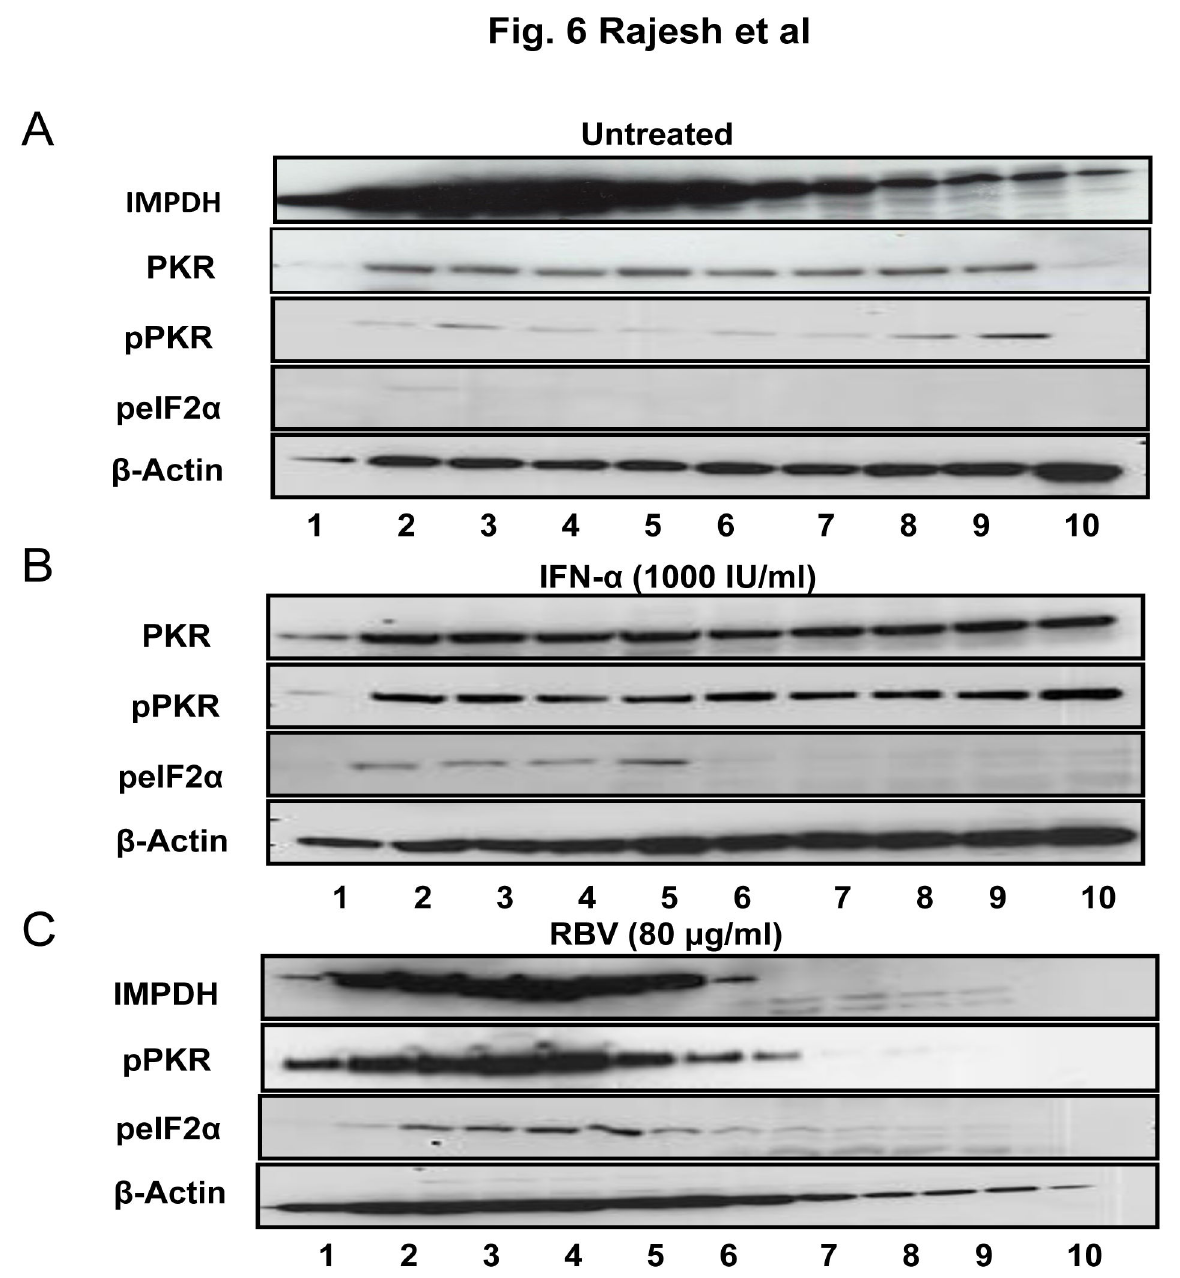
Figure 6. Western blot analysis of polyribosome fractions of HCV IRES-GFP transfected cells. ( A ) Untreated HCV IRES- GFP transfected cells showing IMPDH, PKR, pPKR is bound to the ribosome throughout the gradient. ( B ) PKR induced peIF2α protein is found in the monosome-containing fractions (lanes 1-5) and absent in the higher density polyribosome fractions (lanes 6-10) due to IFN-α treatment. ( C ) IMPDH, pPKR and peIF2α proteins were found in the monosome fractions (lanes 1-6) but excluded from the high-density polyribosome fractions (lanes 6-10). The level of actin was detected throughout the gradient. doi: 10.1371/journal.pone.0072791.g006 expression of interferon-stimulated genes (ISG), (v) RBV also mechanisms inhibition of cellular IMPDH by RBV has been inhibits cellular eIF4E activity required for translation of viral verified by a number of laboratories using HCV and other virus genome, and (vi) RBV helps to clear the virus by stimulating infection models [34–37]. Molecular studies of RBV action the T helper 1 response of host. Among these candidate against HCV are possible due to the availability of in vitro cell